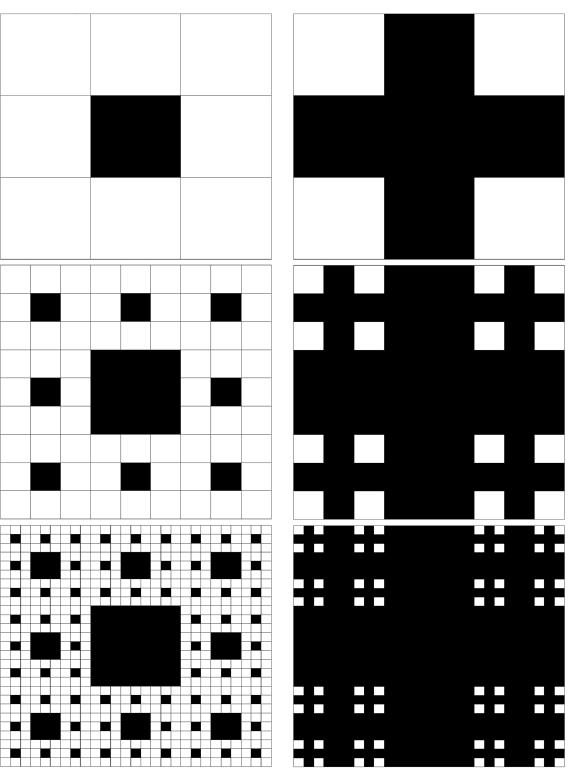
Fig. 7 Comparison between the Taj Mahal garden layout and a Sierpinski carpet. For the Sierpinski carpet (left), the starting point, or a basic unit, of the iteration process is a square divided into nine equal squares. At each scale, the middle square is removed. The process is repeated theoretically in fi nitely. To reproduce a simpli fi ed version of the Taj Mahal layout (right), the process is similar but the basic unit is a square divided into nine squares for which the fi ve center squares have been removed. Although both fi gures are based on simple Euclidean elements, the number of elements they contain increases with each iteration at progressively decreasing scales, which makes them fractal objects.